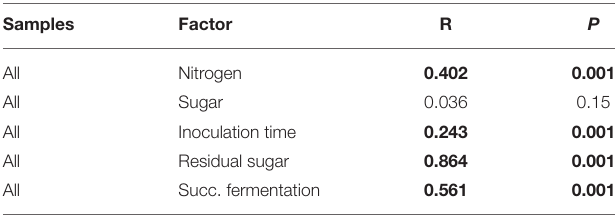
TABLE 2 | ANOSIM of the different factors effect on the fermentations based on a dissimilarity matrix calculated by the Euclidian distance of the kinetic